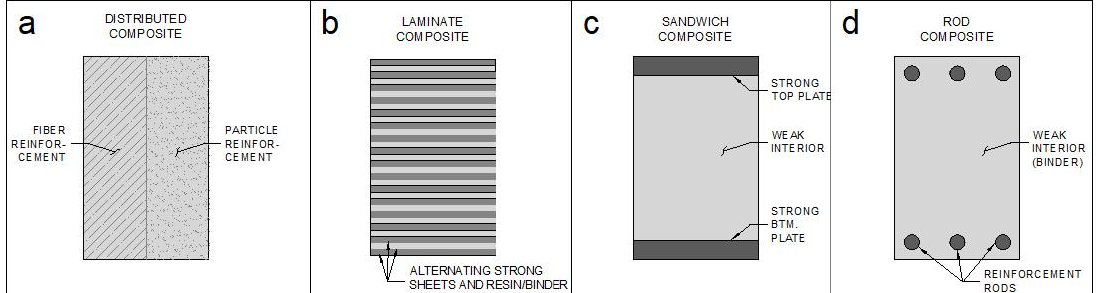
Figure 1. The types of composites: ( a ) Fiber / particle reinforcement distributed throughout the interior of a component. ( b ) Laminate composites, which alternate different materials between layers. ( c ) Sandwich composites. ( d ) Rod composites; these are representative of reinforced concrete.